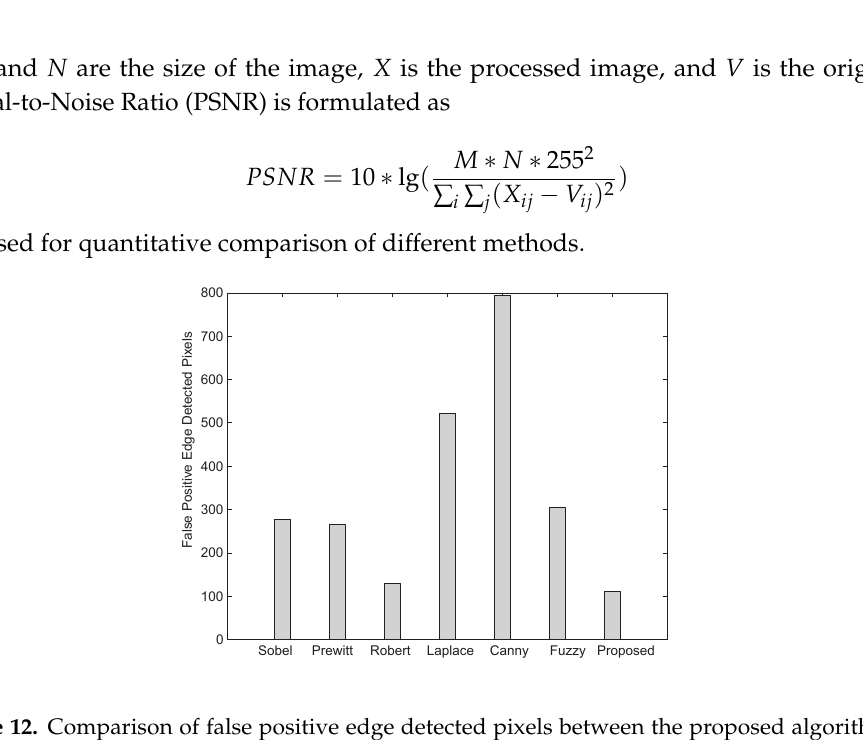
Figure 12. Comparison of false positive edge detected pixels between the proposed algorithm and other conventional ones.